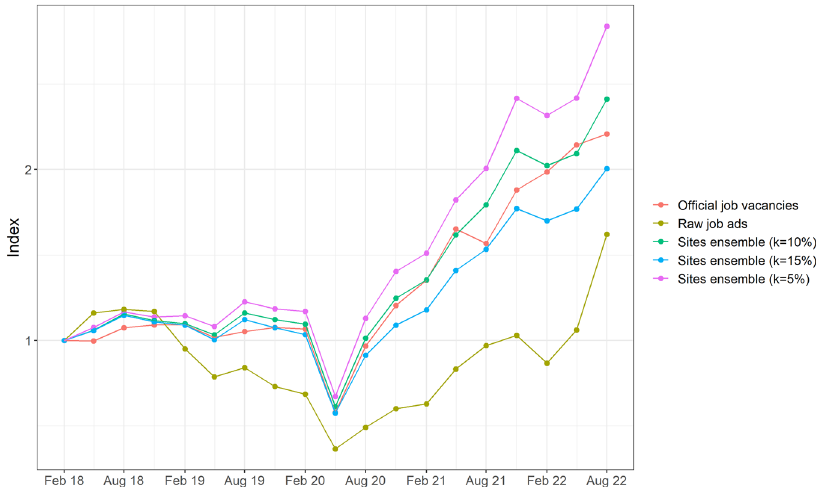
Fig. 5 Actual and predicted index of job vacancies over time. Each method ’ s vacancies index compared to the Job Vacancies Survey ’ s of fi cial vacancies index at the Australia level.